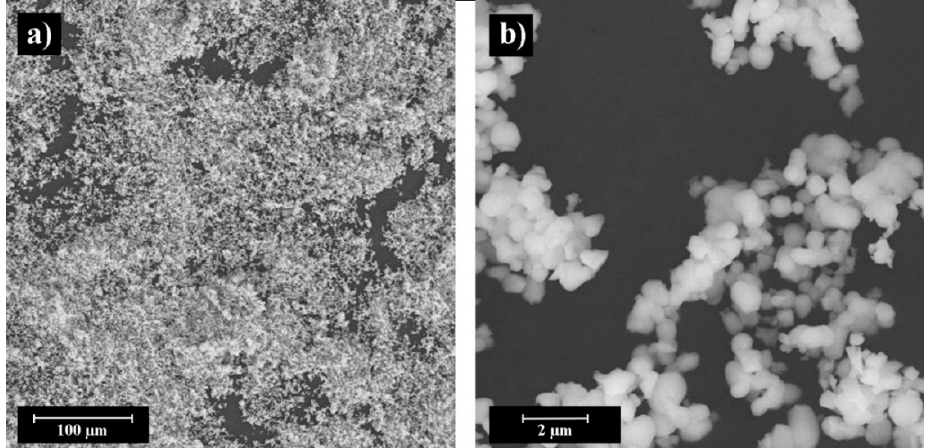
Figure 1. SEM images of C-BaTiO 3 powder at different magnifications: general view ( a ), agglomerate ( b ), powder particles ( c ).